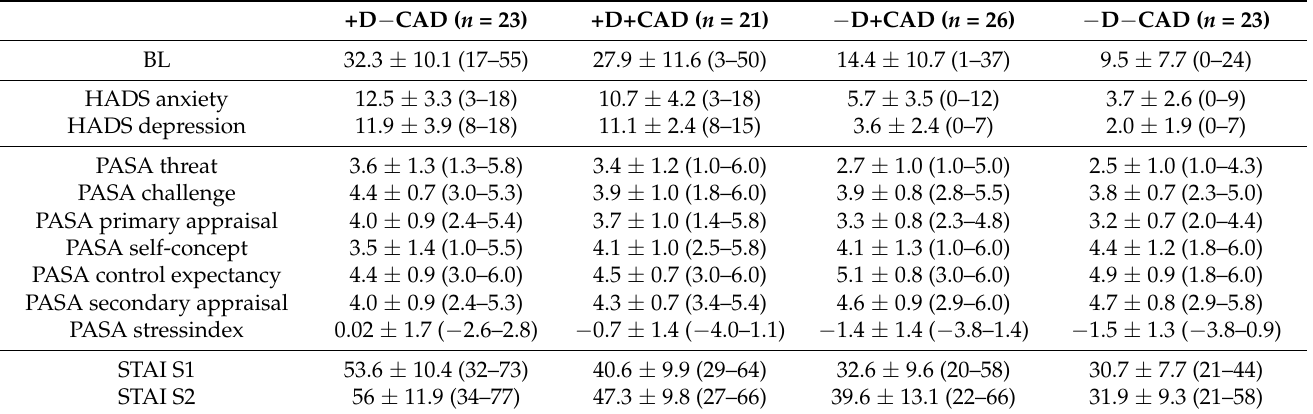
Table 1. Psychological